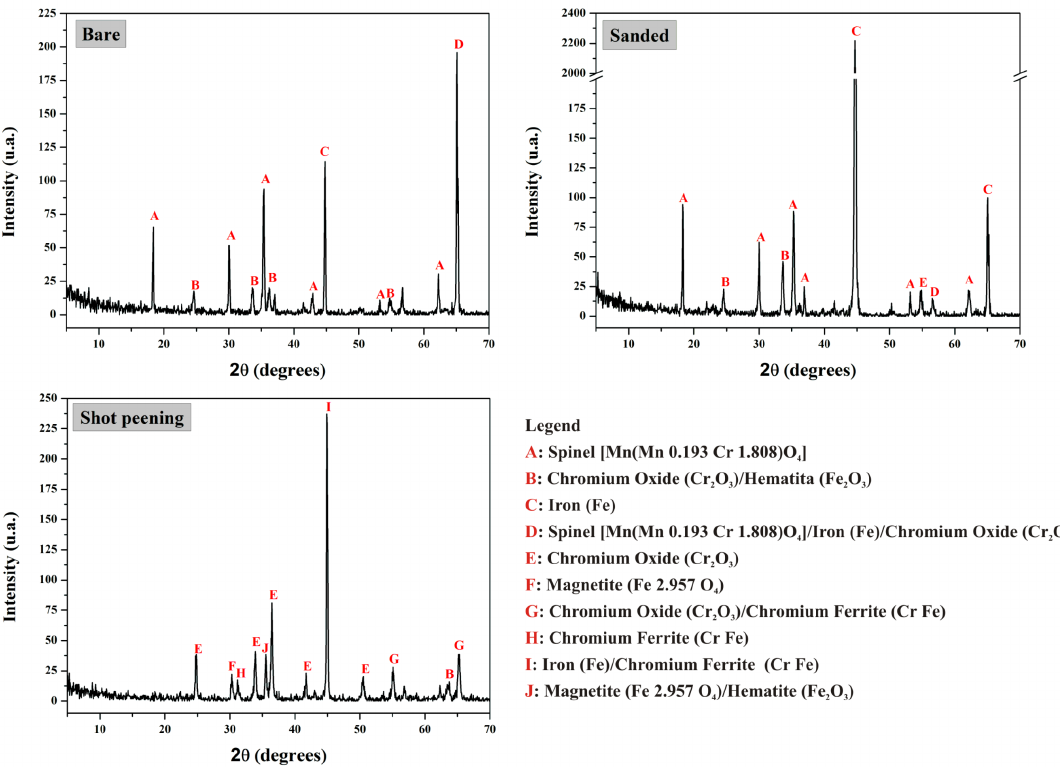
Figure 9. Diffractograms of the samples after the oxidation test.